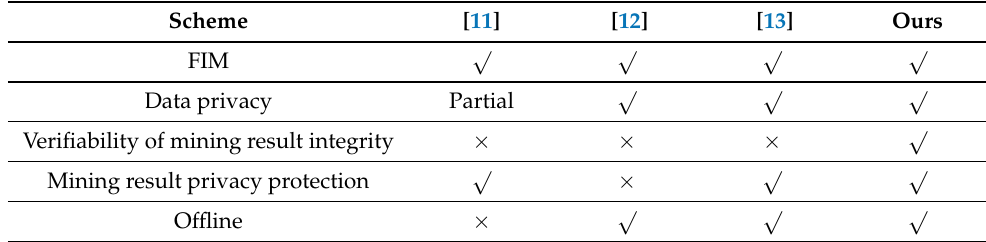
Table 6. Comparison of